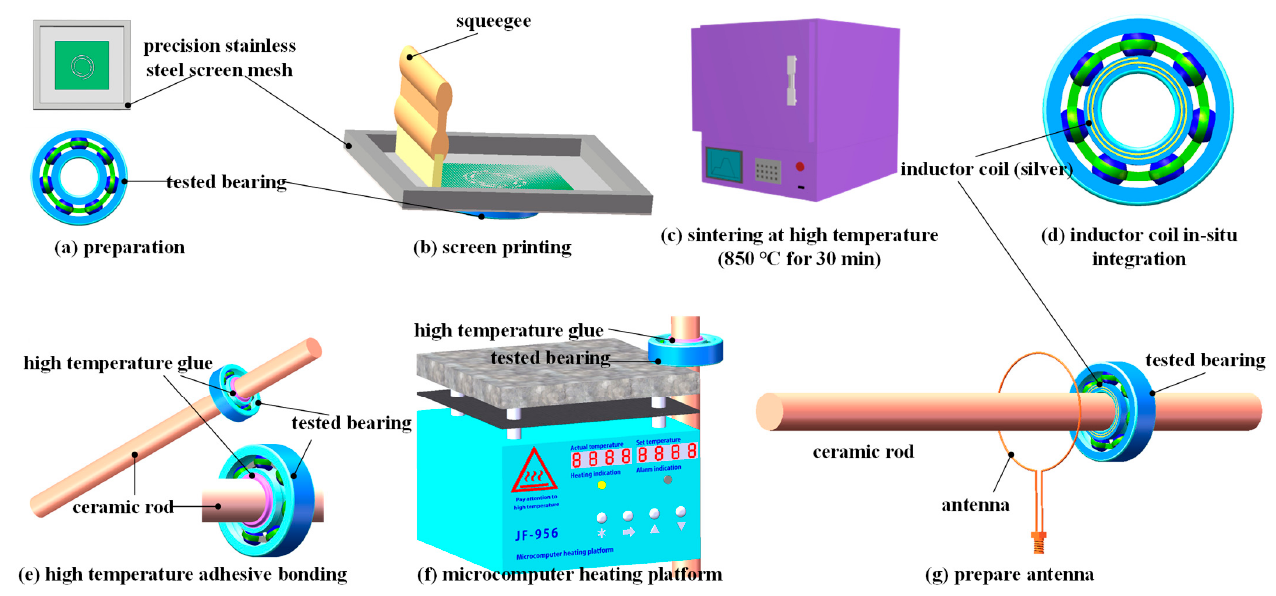
Figure 1. Fabrication of a printed temperature sensor using screen